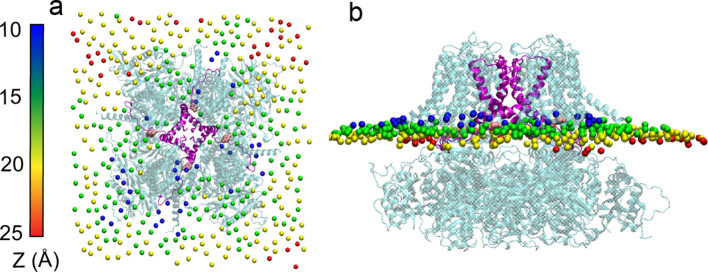
A representative snapshot of metal-bound K0 channel showing membrane distortion around the protein.(a) Top view, (b) side view. The POPC phosphorous atoms have been colored according to their distances to the membrane center. S6 helices are colored in magenta and Tyr 330 side chains are shown as pink spheres.